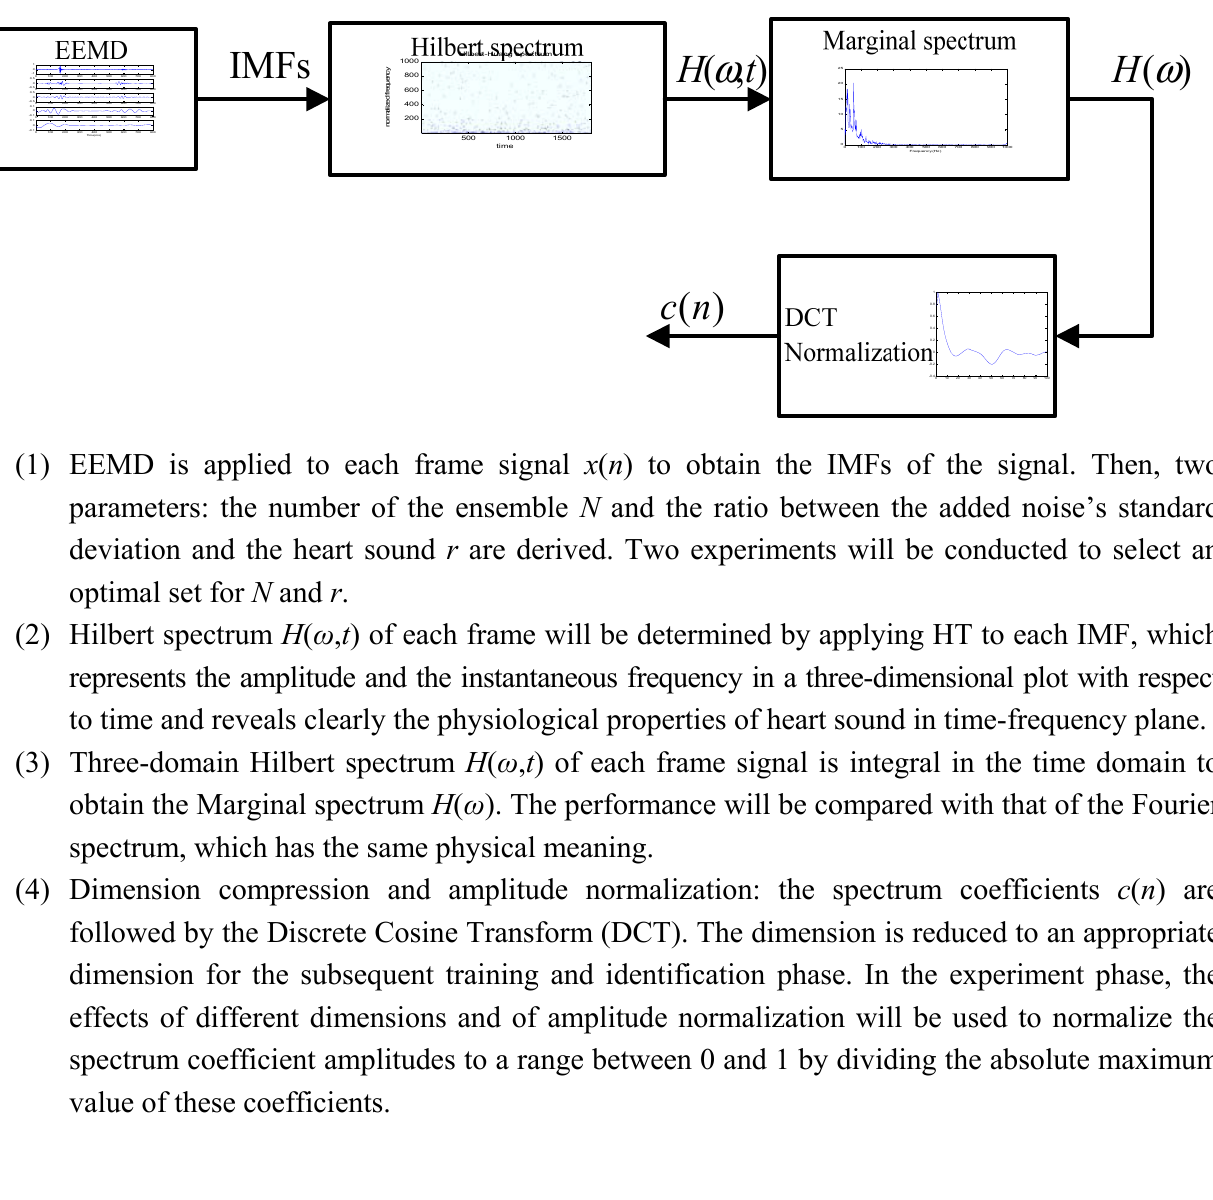
Figure 9. Block diagram of feature extraction